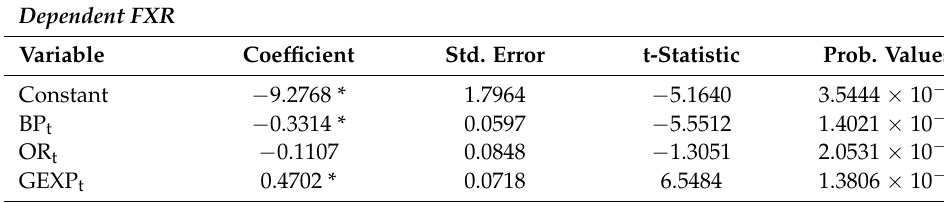
Table 5. Foreign exchange rate, long-run